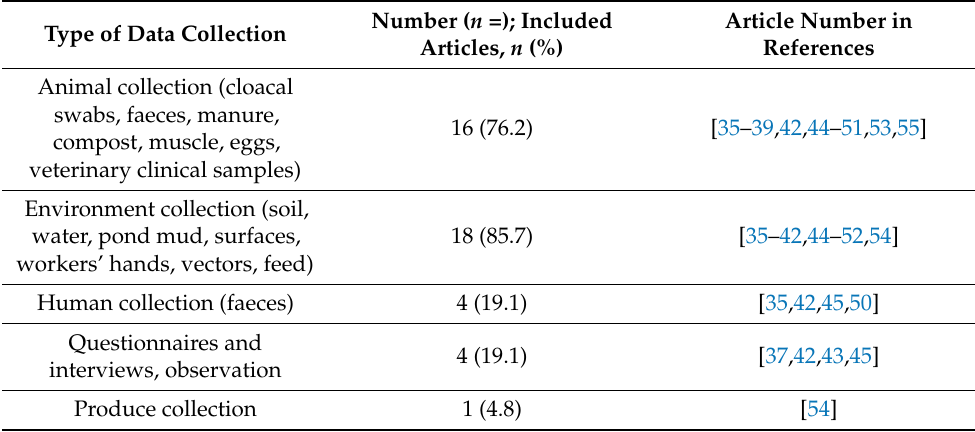
Table 3. Data collection sources/instruments used in selected